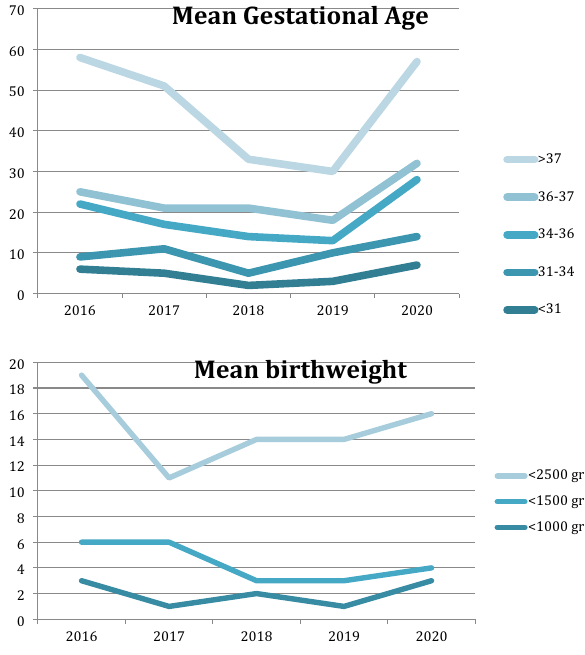
Figure 1. overview in demographic data from 2016 to 2020 of patients requiring NETS included in our study. ( a ) shows overview the trend of the mean GA, and ( b ) mean birth-weight during the study period. The average birth weight of infants is 2484 g (600–5050 g). The proportion of infants with birthweight < 1000 gr is stable at 4.5%; the proportion of infants weighing < 1500 gr was 4.5% in 2016 and 1.6 in 2020%; the proportion of infants weighing < 2500 gr is stable 18–19%.